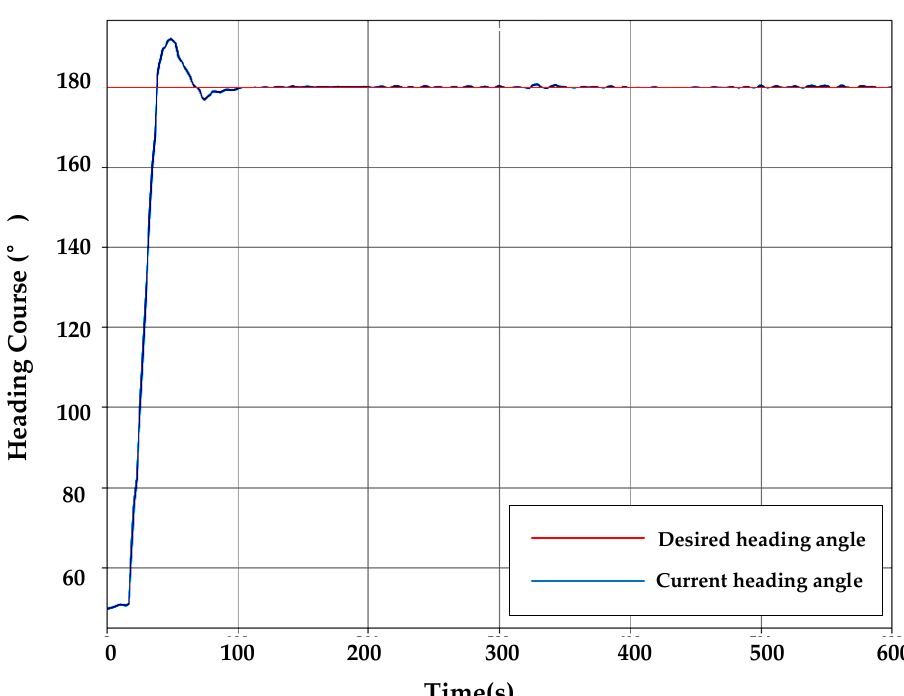
Figure 11. Test Results of PID Control for Heading orientation experiment.